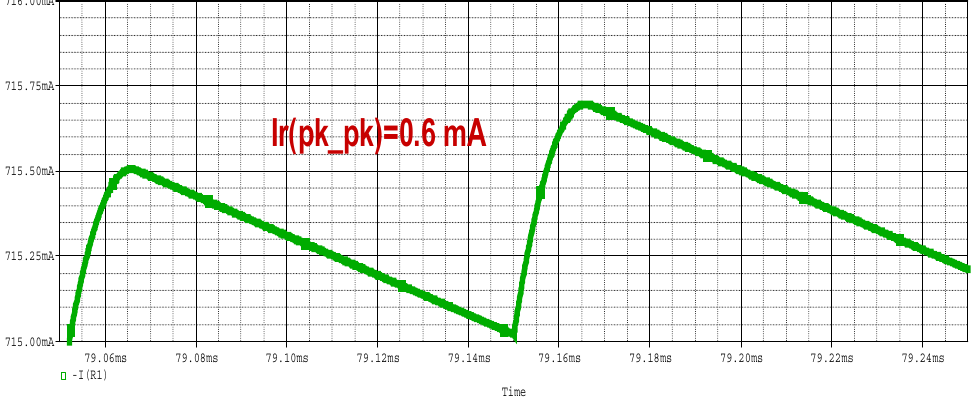
Figure 23. Magnitude of output current ripples for converter [7].